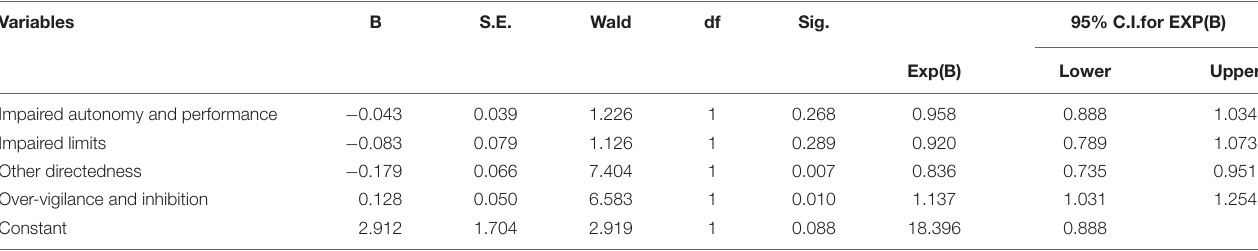
TABLE 2 | Logistic regression—variables in the equation and coefficients. Variables